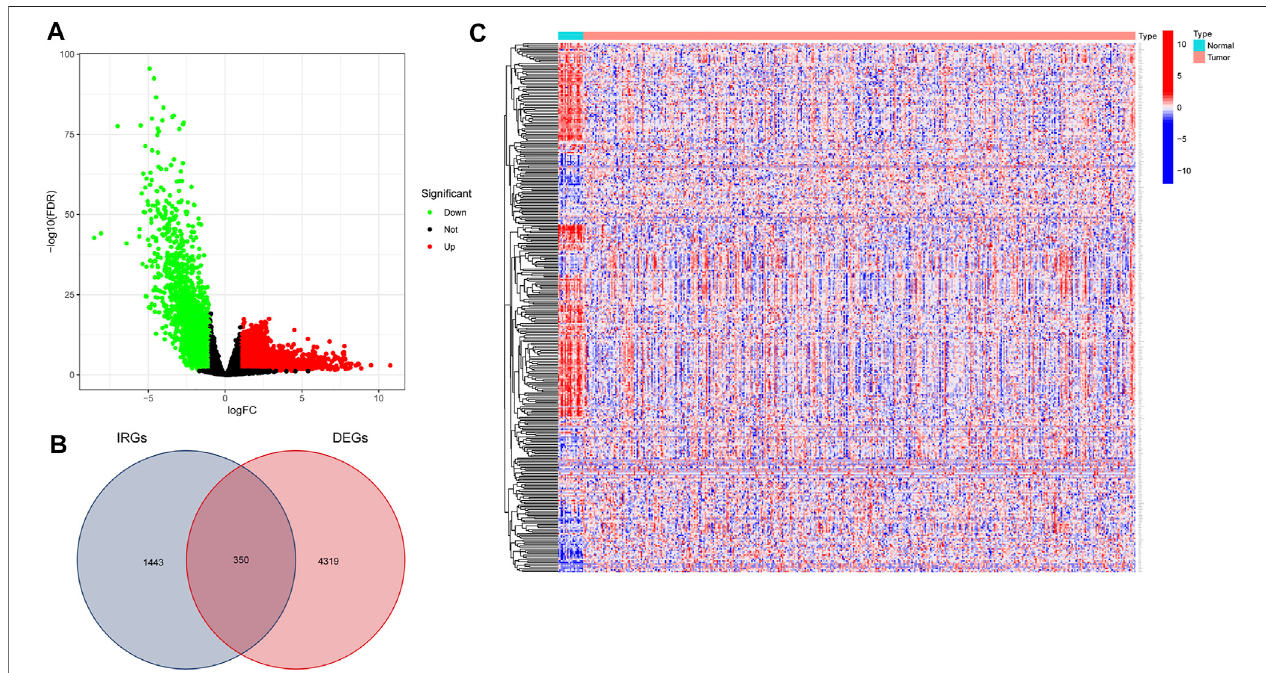
FIGURE 1 | Screening for immune-related differentially expressed genes (DEGs) in bladder urothelial carcinoma (BLCA). (A) Volcano plot showing DEGs between tumorandnormaltissuebasedonTheCancerGenomeAtlas(TCGA)databaseofBLCAsamples. (B) VennplotshowingtheintersectionanalysisofDEGswithimmune- related genes (IRGs) from the Immunology Database and Analysis Portal (ImmPort) database. (C) Heat map of immune-related